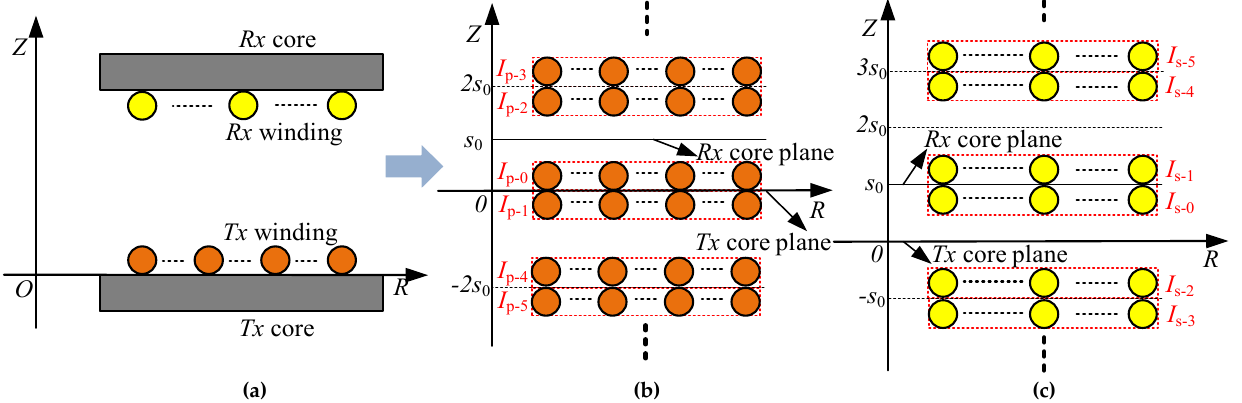
Figure 6. The method of images equivalent model. ( a ) The magnetic coupling system model; ( b ) The method of images model of transmitter winding current; ( c ) The method of images model of receiver winding current.